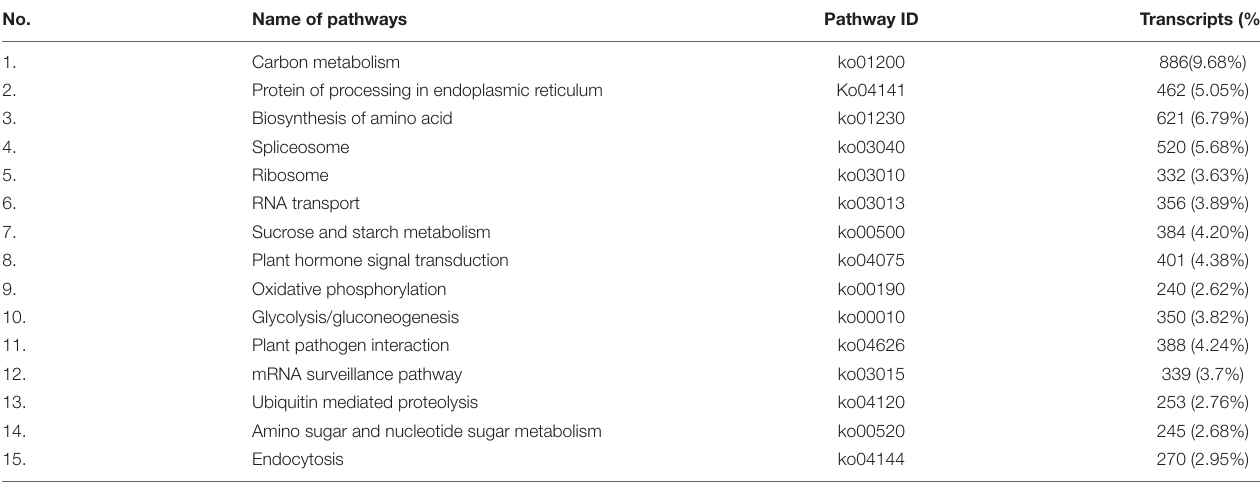
FIGURE 7 | COG annotation classification statistics of transcripts. TABLE 4 | Topmost pathways annotated by the KEGG